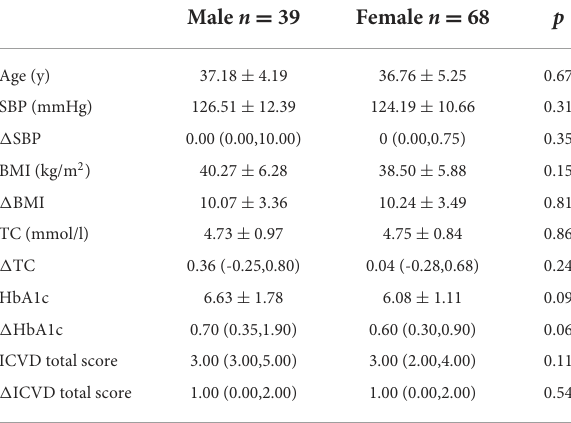
TABLE 6 Baseline and 6-month-post-operative characteristics in the non-diabetic subgroup.